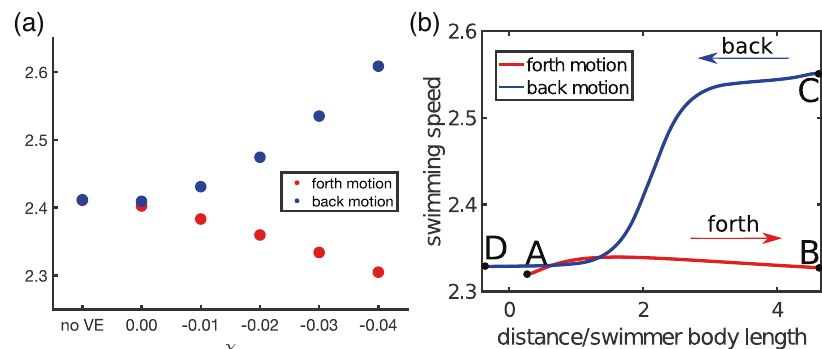
Fig. 3 Swimming speed for motion reversal on the same track. A pusher ( β = − 2) with planar anchoring ( W = 0.5) swims horizontally (parallel to n ∞ ) towards the bouncing point (forth motion) and switches to the opposite direction after reaching the bouncing point (back motion) a Average speed of the microswimmer within one body length from the bouncing point. The case “ no VE ” corresponds to the motion in the pure liquid crystal when viscoelasticity is turned off. b Swimming speed vs position of the swimmer for χ = − 0.03. Point A corresponds to the starting point for the forward motion and point B to the fi nal point. Points C and D correspond to the starting and fi nal point of the backward motion.